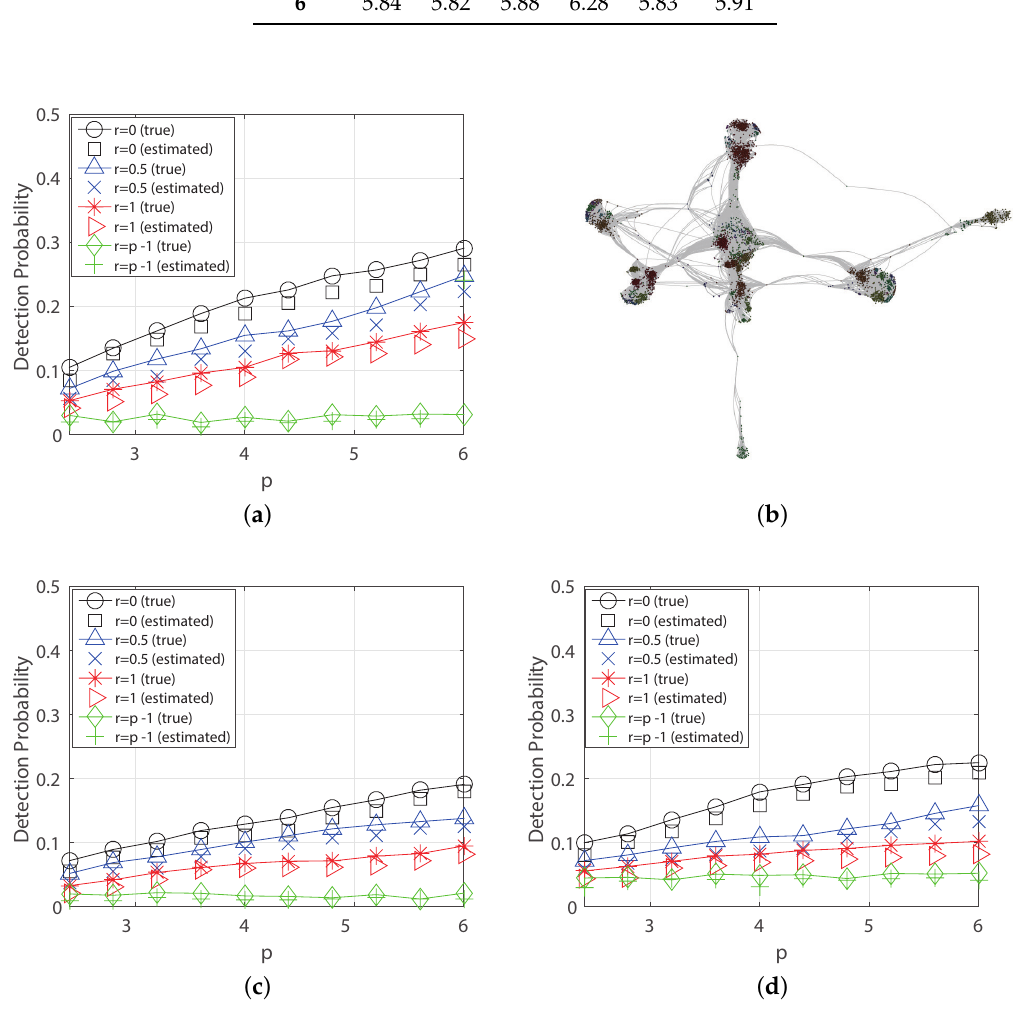
Figure 7. Detection Probabilities (true and estimated parameter) for Real-world Networks (( a ) US power grid network, ( b ) Facebook Network [21], ( c ) Facebook network, and ( d ) Wiki-vote network ( K =